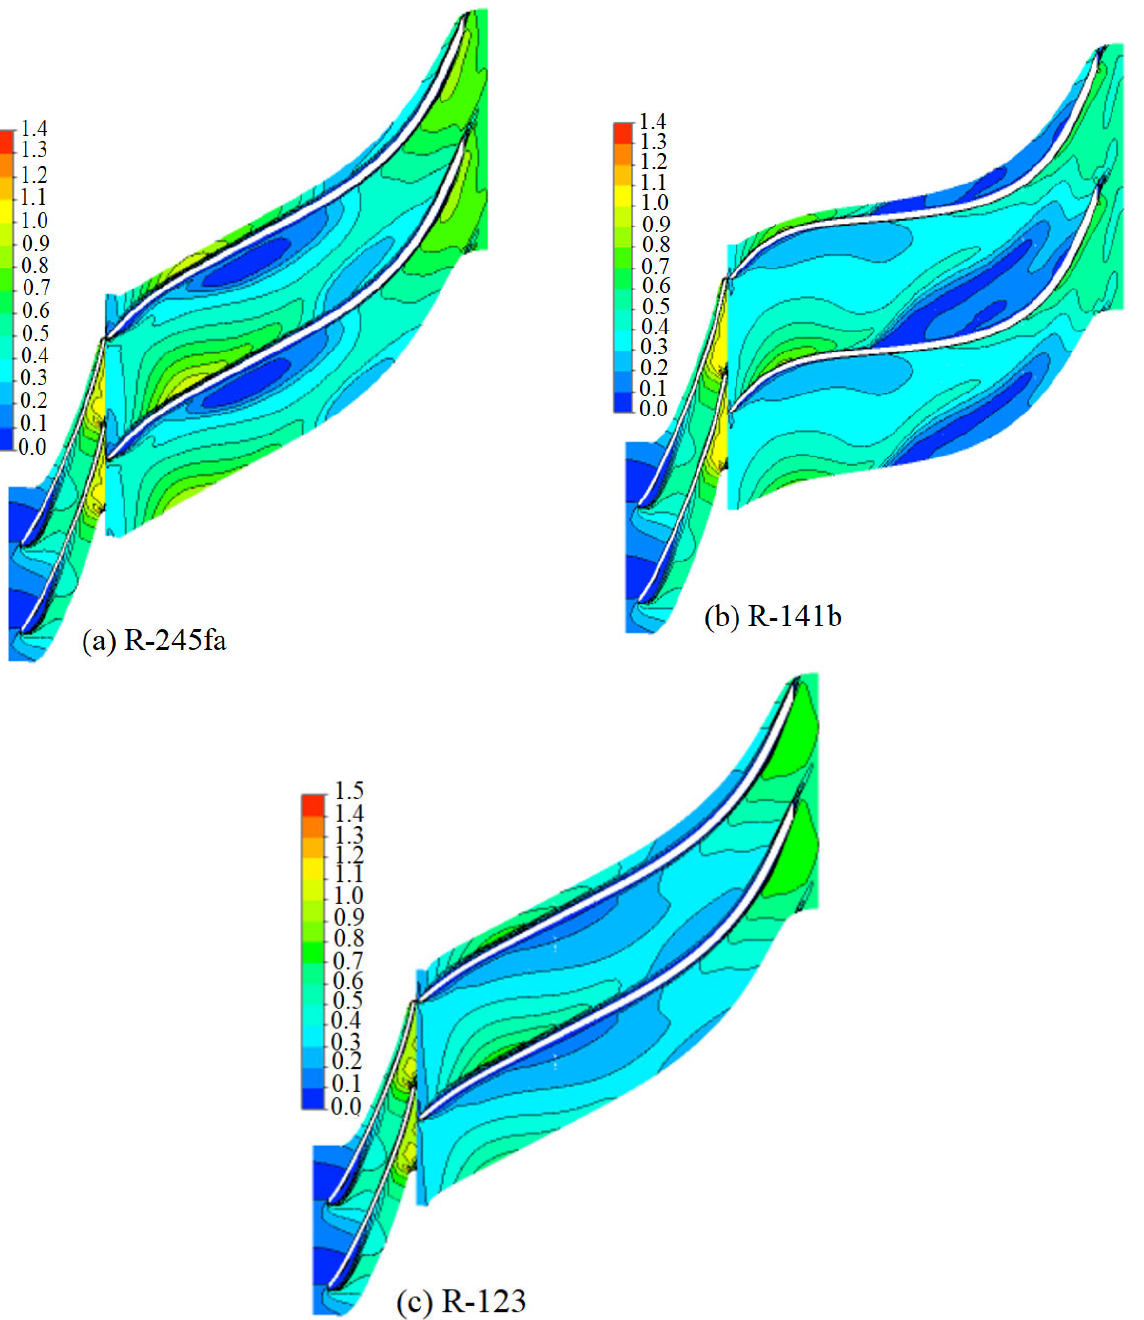
Figure 10. Distribution of the Mach number in the nozzle ‐ rotor at 50% meridional plane height.